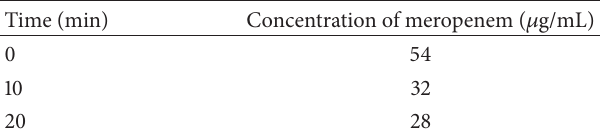
Table 1: Serum meropenem concentrations given as a 30-minute infusion of 30 mg/kg, every 8 hours.